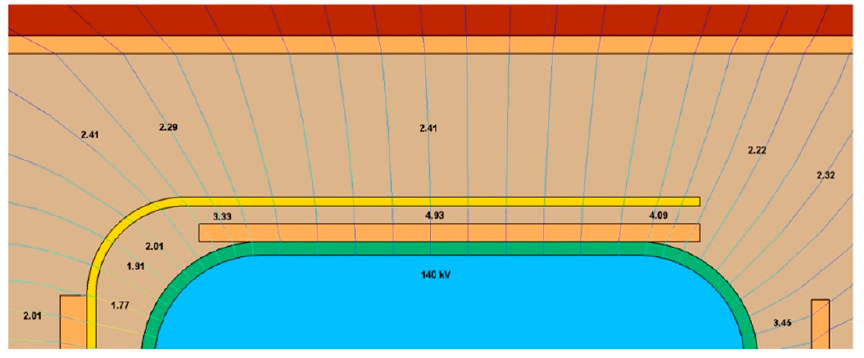
Figure 10. Safety factors for top winding.